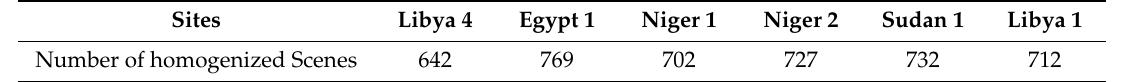
Table 11. Total number of scenes used for each site in trend analysis.